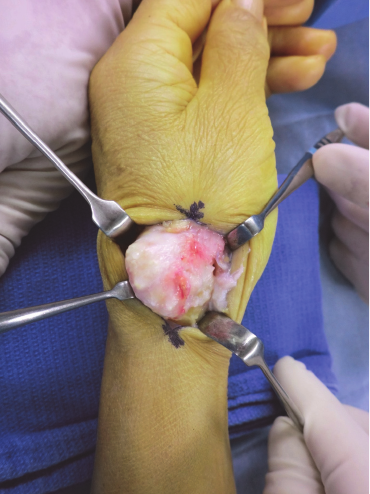
Figure 4: An intraoperative photograph showing marginal incision of the